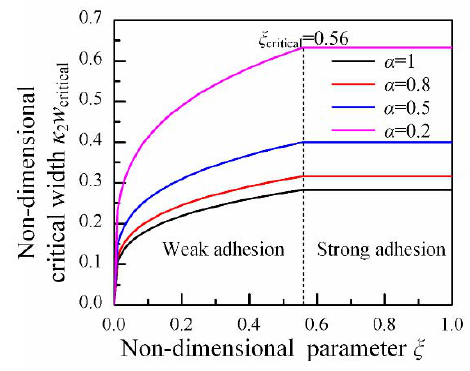
Figure 3. The non ‐ dimensional critical conformal width 2 w  critical with  for 1%   critical and Figure 3. The non-dimensional critical conformal width κ 2 w critical with ξ for ε critical = 1% and ν island = 0.32. Two regions, weak adhesion and strong adhesion, are divided by ξ critical = 0.32  island = .Two regions, weak adhesion and strong adhesion, are divided by